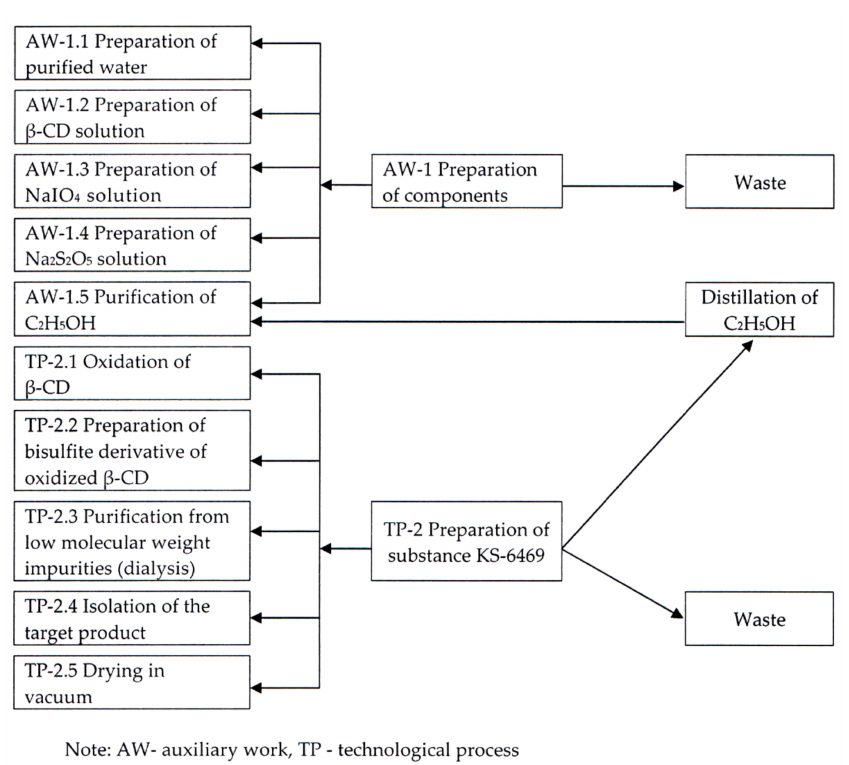
Figure 2. Technological scheme of obtaining the substance KS-6469 (laboratory